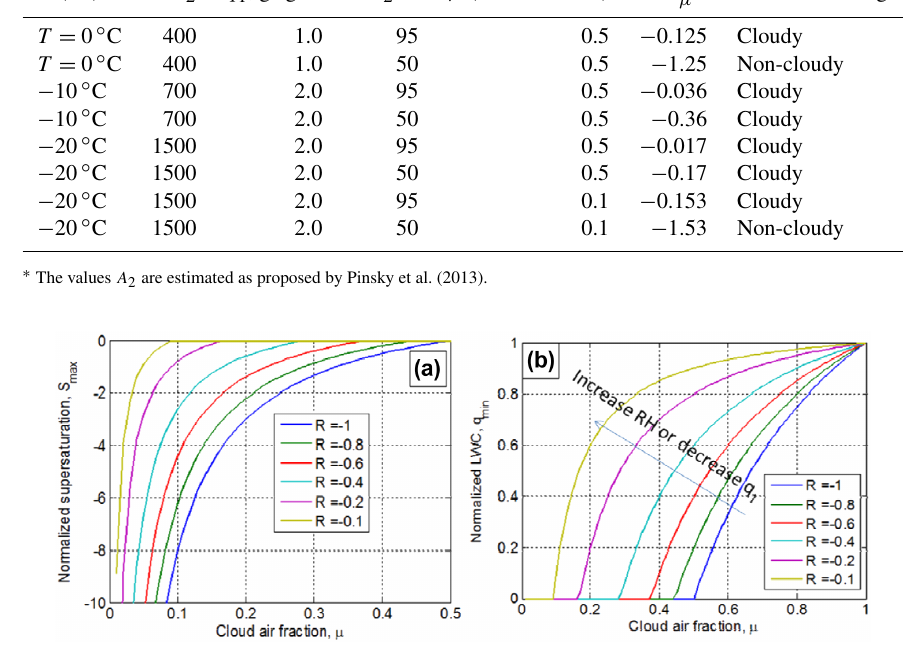
Figure 6. Dependencies of normalized equilibrium supersaturation e S max (a) and normalized equilibrium LWC (which is equal to normalized equilibrium liquid water mixing ratio) e S max (b) on cloudy air fraction at the final stage of homogeneous mixing. Curves of different colors correspond to different values of non-dimensional parameter R = S 2 A 2 q 1